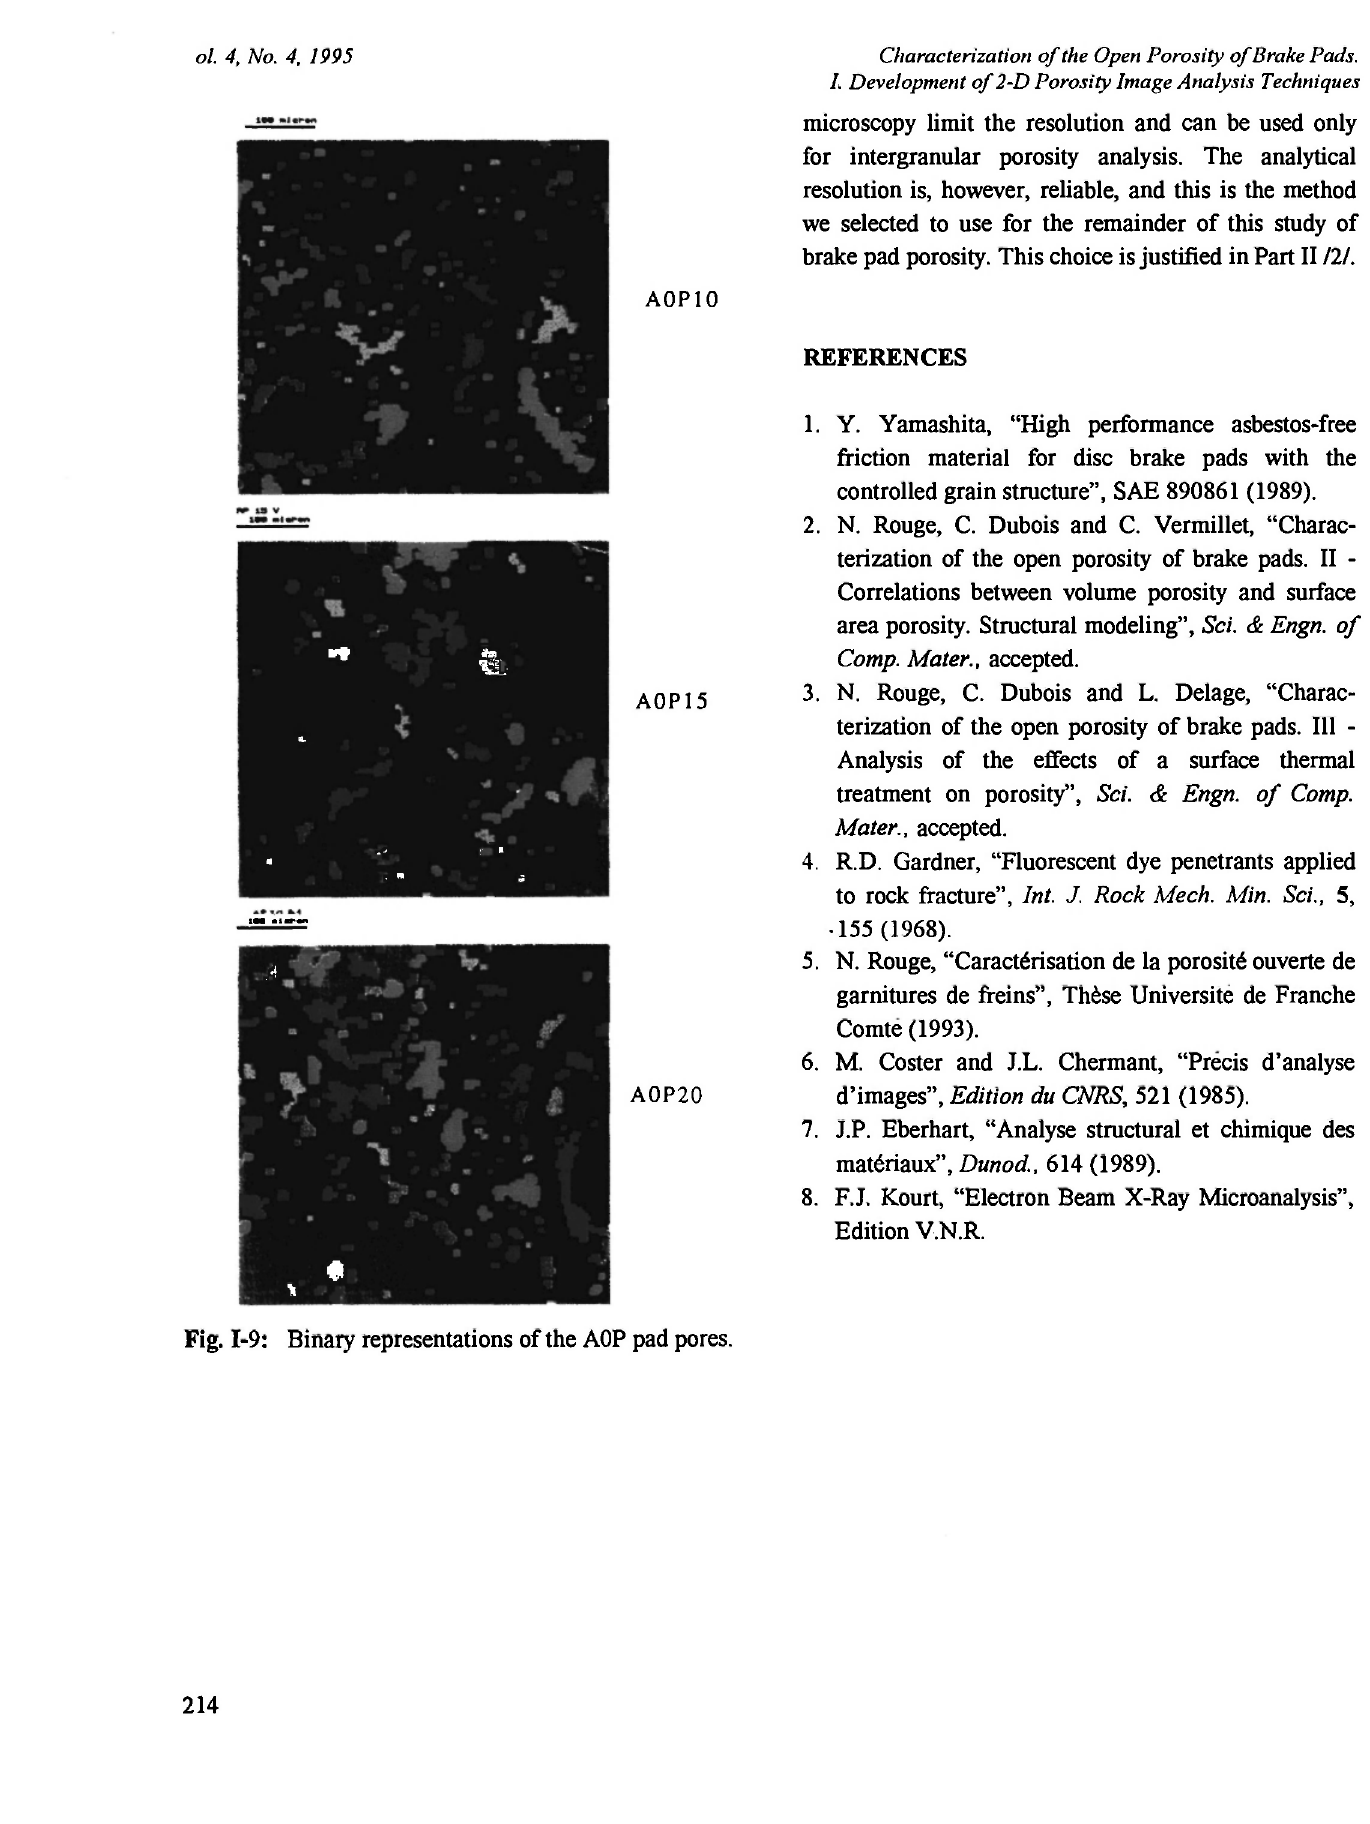
Fig. 1-9: Binary representations of the AOP pad